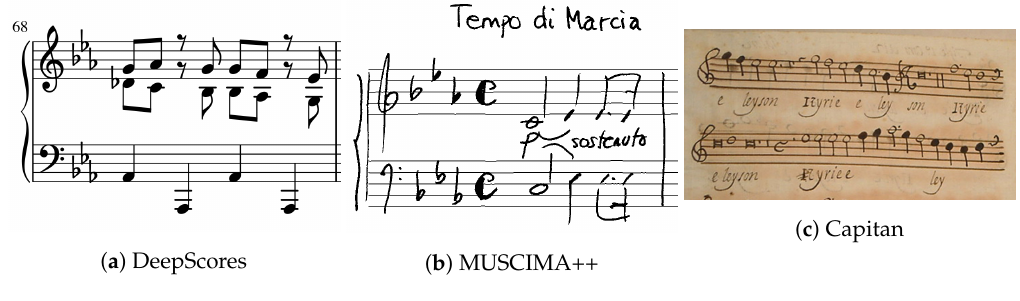
Figure 3. Samples of notation from the considered